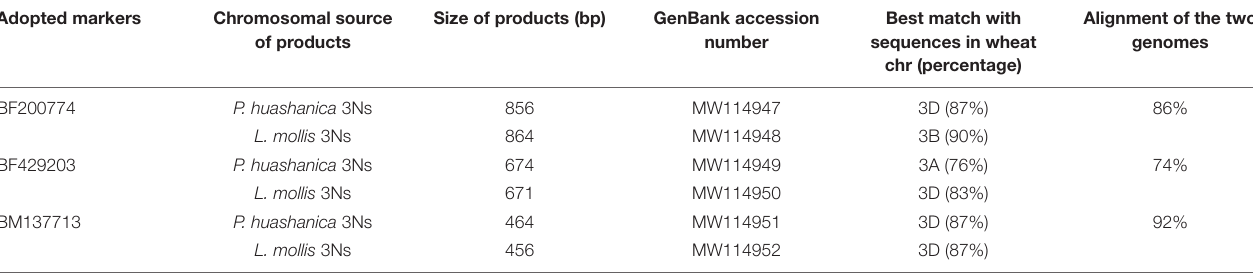
TABLE 2 | Analysis of the Ns genome–specific bands amplified in DH109 and DM131 by three EST-STS markers. Adopted